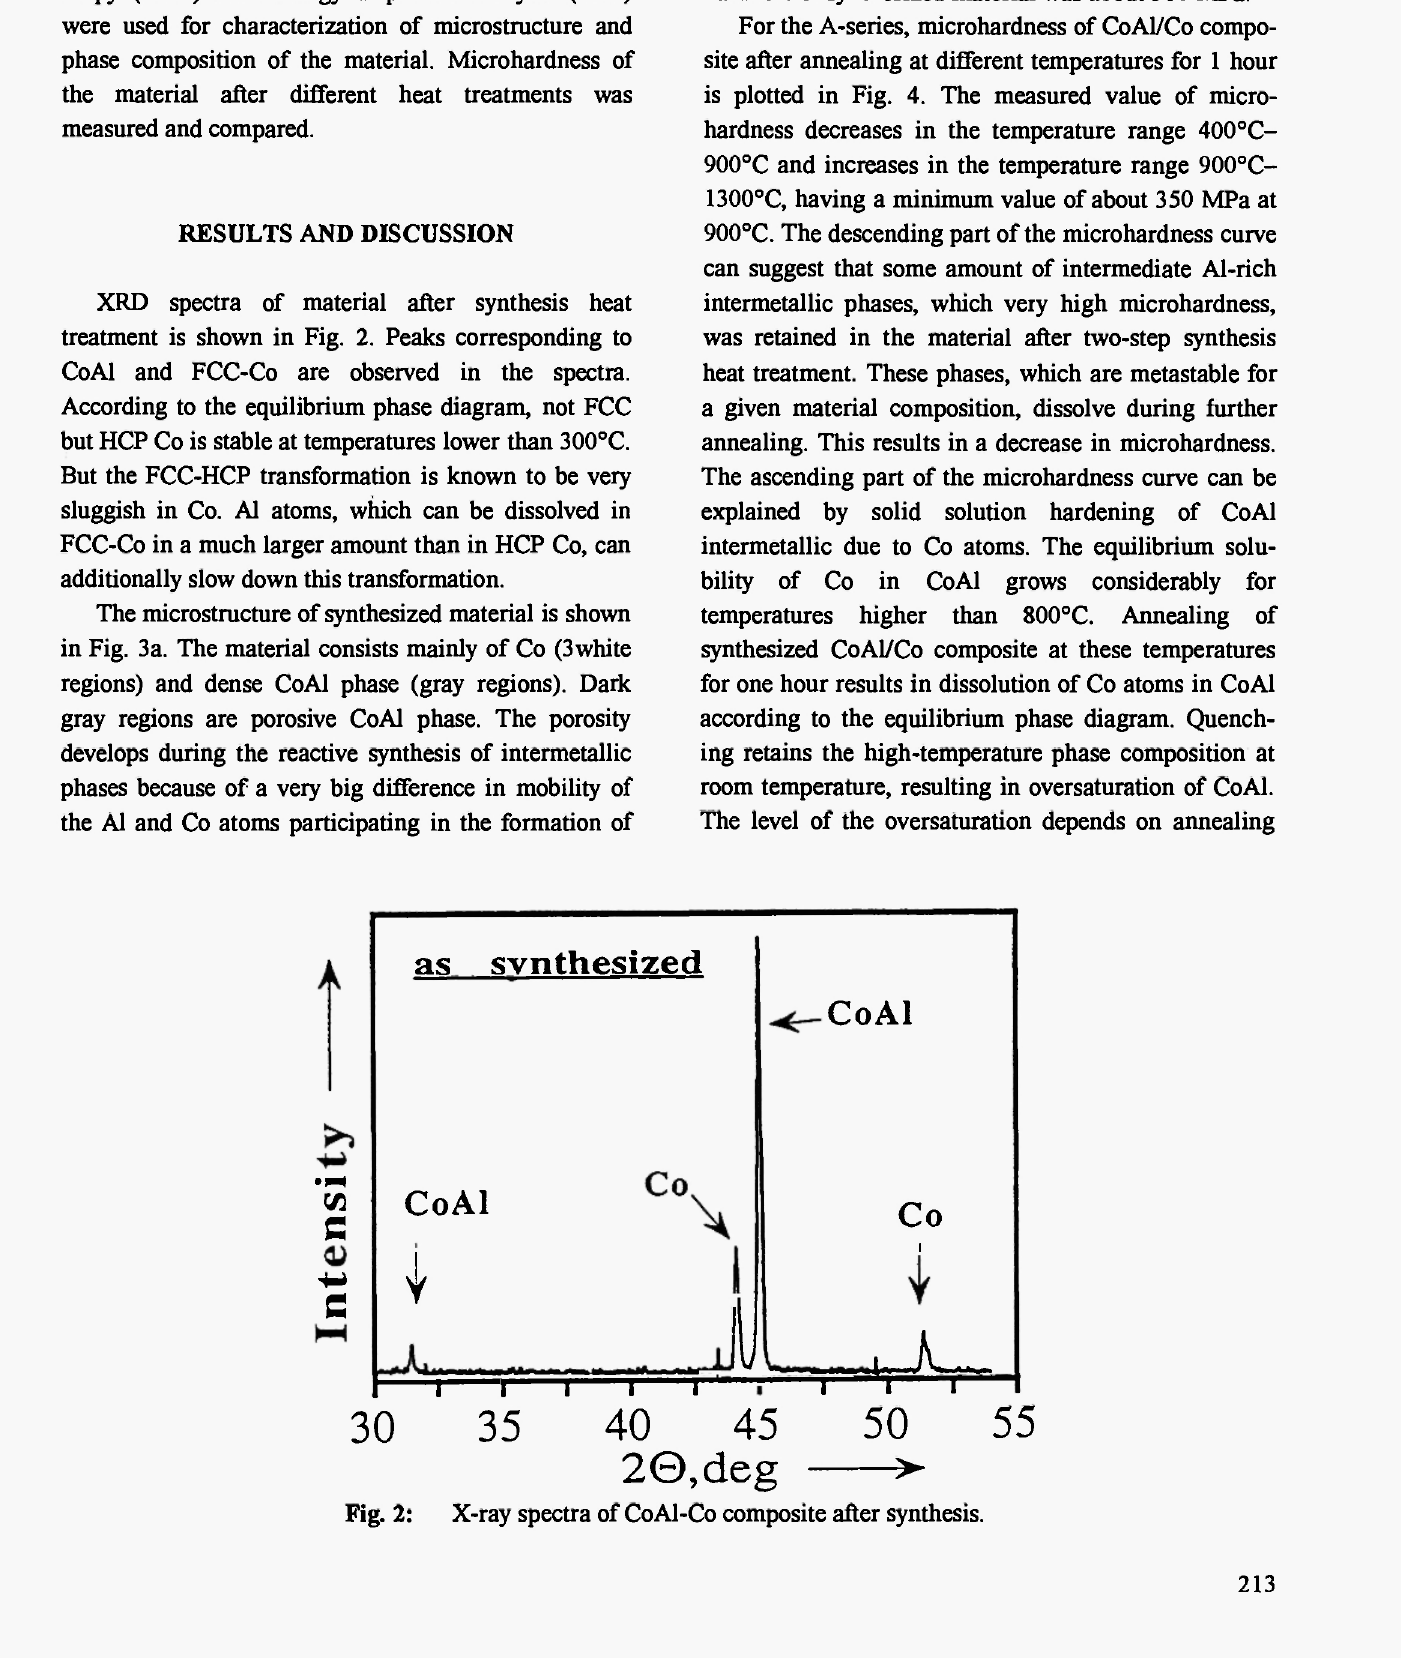
Fig. 2: X-ray spectra of CoAl-Co composite after